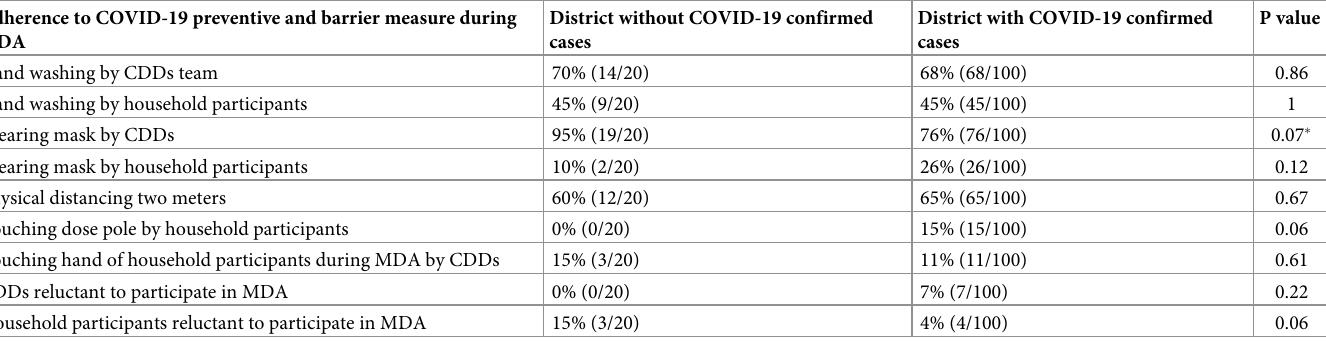
Table 2. Observative results on adherence to COVID-19 mitigation measures during MDA from 14 districts in 2020 in Guinea. Adherence to COVID-19 preventive and barrier measure during